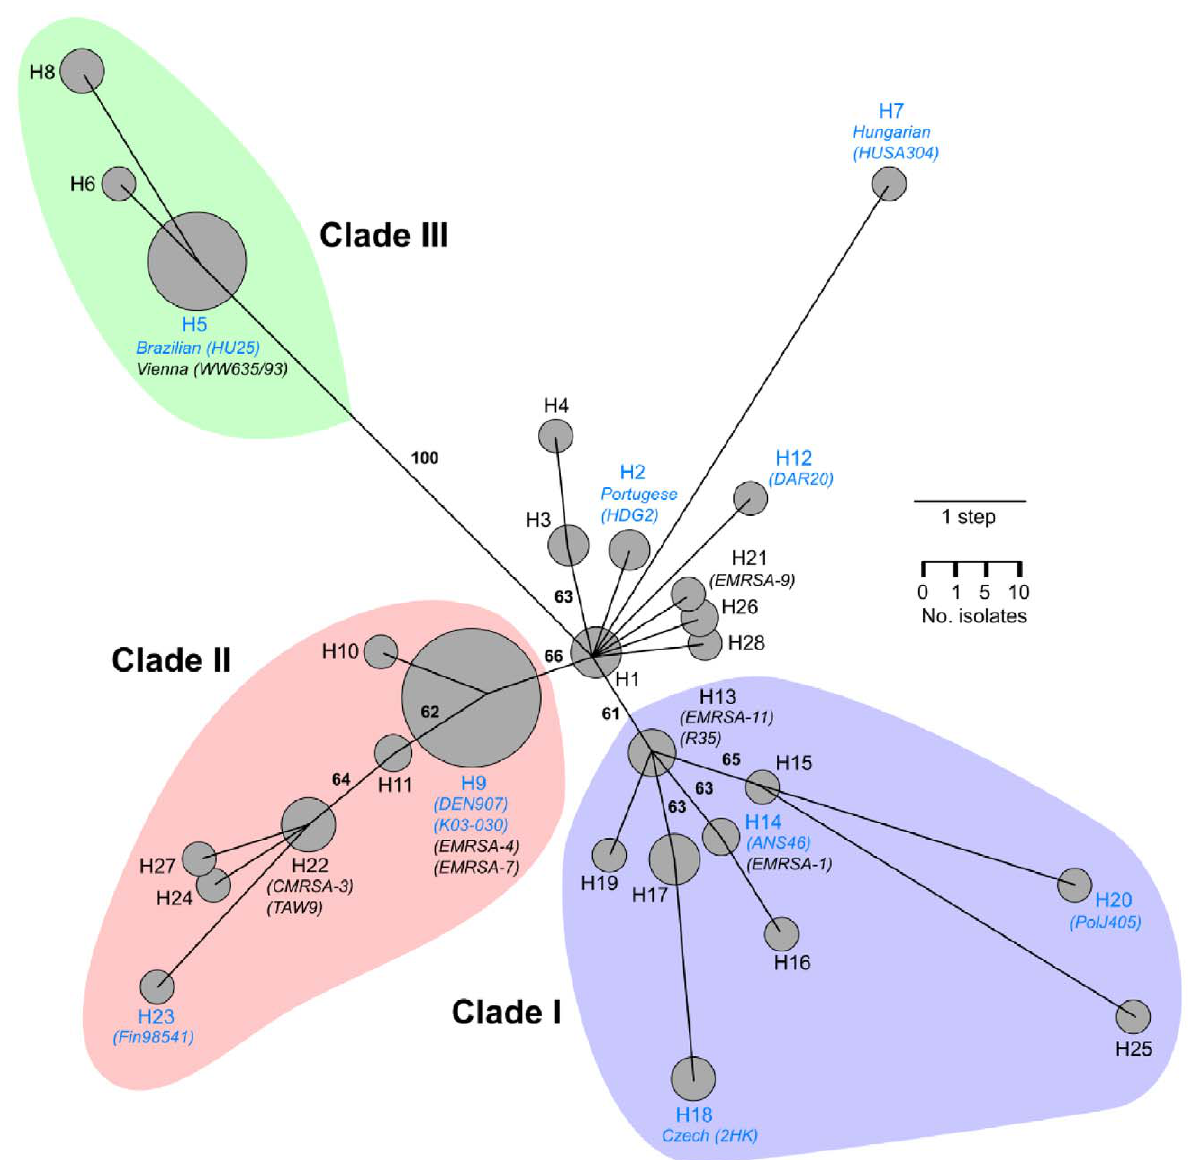
Figure 1. Evolutionary relationships within the ST239 clonal group. Tree is the most parsimonious haplotype tree found by heuristic search. Haplotypes are numbered H1–H28. Circles represent the number of isolates of each haplotype. Names of important strains are indicated in parentheses below select haplotypes. Blue labels indicate the discovery panel of isolates. Numbers along branches are bootstrap proportions. Three prominent clades are highlighted.